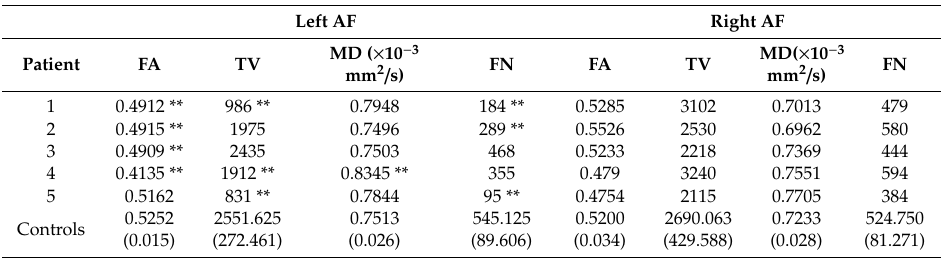
Table 2. Di ff usion tensor image (DTI) parameter values of the arcuate fasciculus of patients and control subjects ( n =